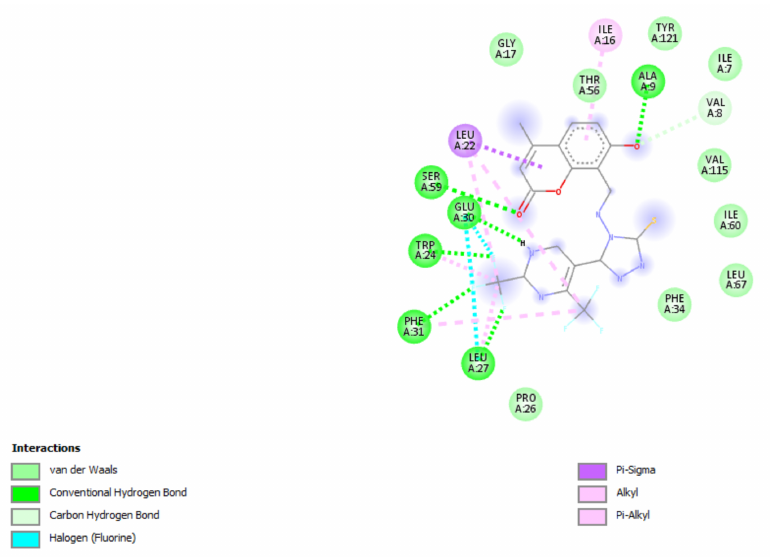
Figure 11. Docking interactions of the designed compound h with DHFR enzyme of